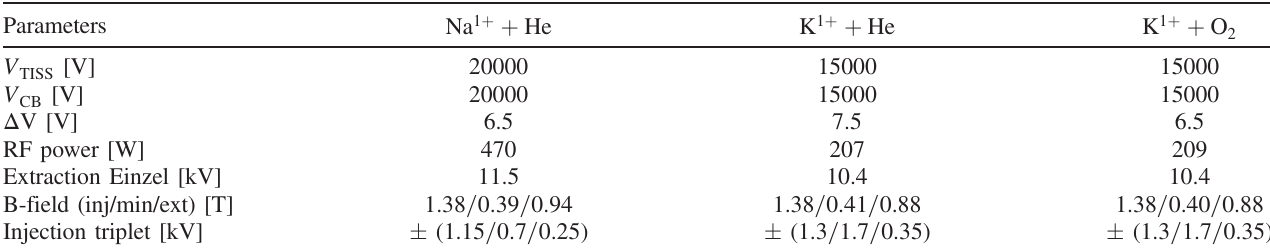
TABLE II. Typical optimum parameters obtained from the charge breeding efficiency measurements.